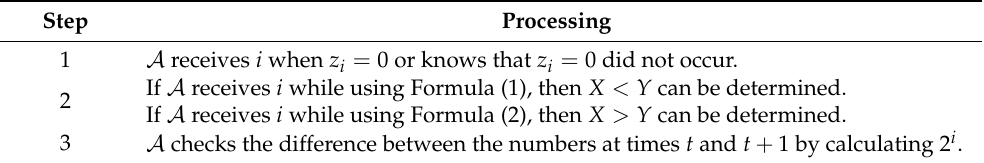
Table 5. Comparison Protocol of A